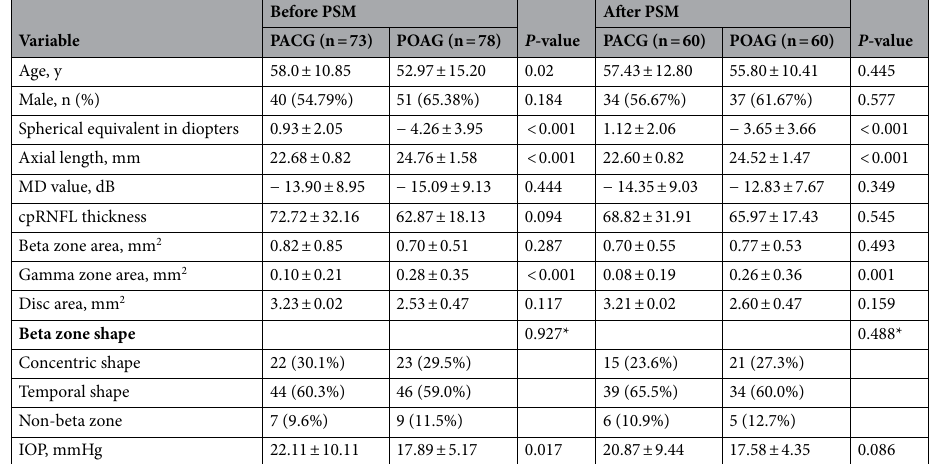
Table 1. Demographic and clinical characteristics of patients before and after PSM in PACG and POAG groups. PSM: propensity score matching; PACG: primary angle-closure glaucoma; POAG: primary open angle glaucoma; MD: mean deviation; RNFL: retinal nerve fiber layer; IOP: intraocular pressure. *Chi-square test was performed to compare the proportions of beta zone shape between POAG and PACG